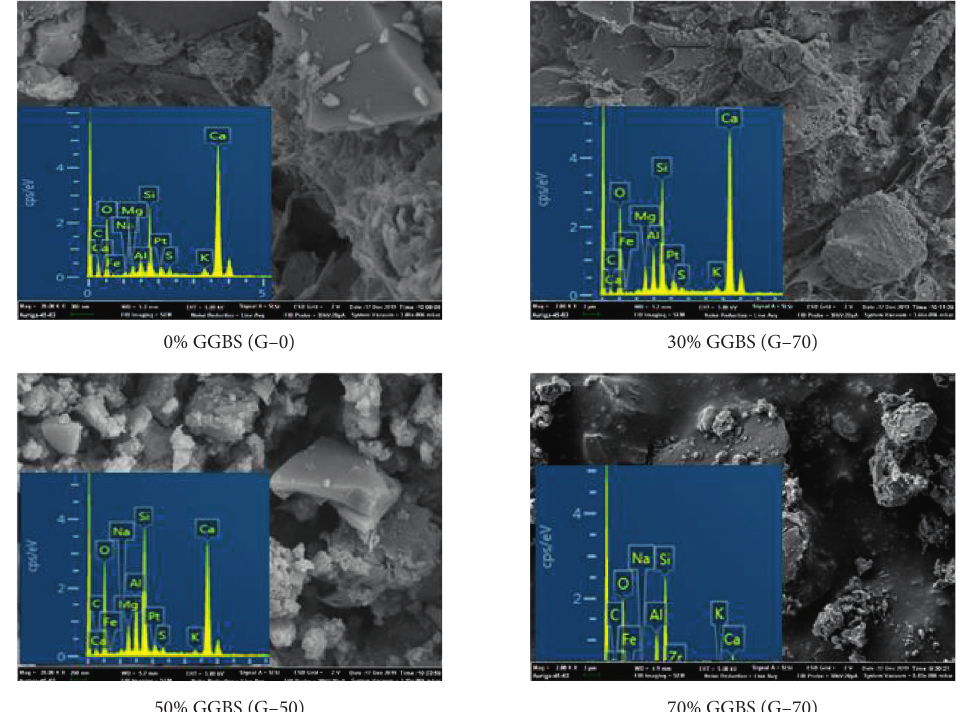
Figure 10: SEM and EDS images of carbonated concrete specimens after natural carbonation